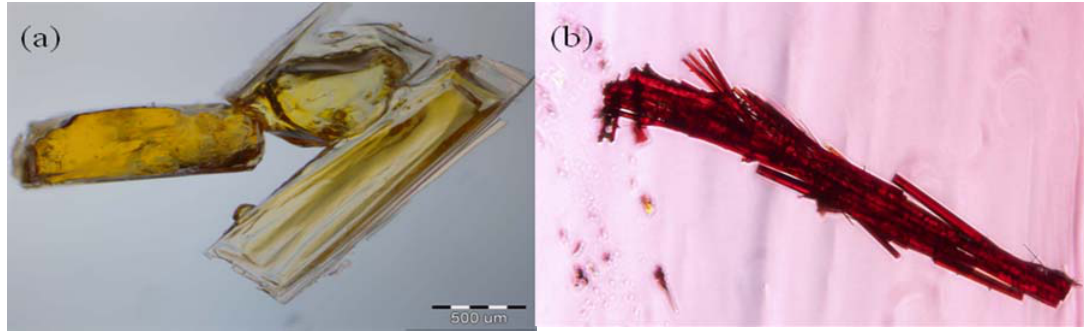
Figure 3. Optical microscope photographs of (a) Ti-FI ligand (b) Ti-FI